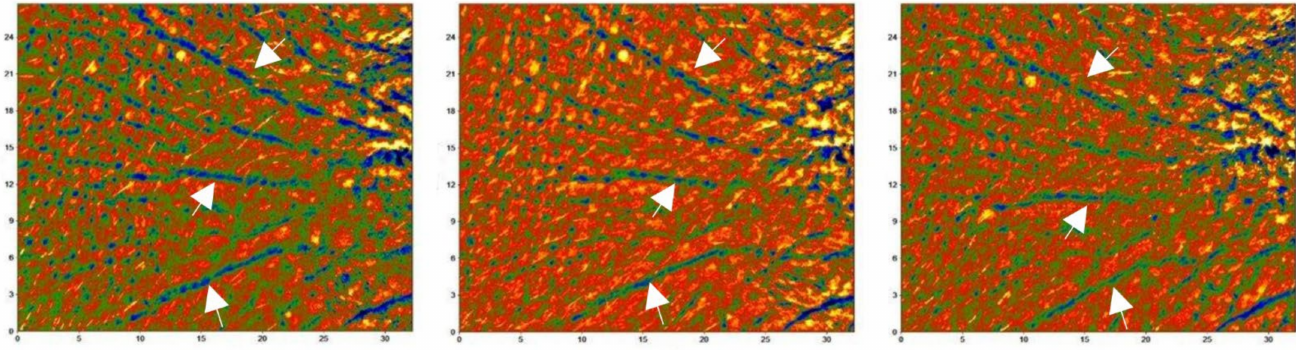
Figure 4. Primos CR pictures before and after product use. The picture shows the product effect in decreasing the mean deepest wrinkle in one of the subjects showing the best effect. A decrease in wrinkle depth (arrows) can be seen as a decrease in the darker colors in the LUT below each image. The image size is 27 (h) × 32 (w) mm. Legend. (from − 500 µ m [black] to 350 µ m